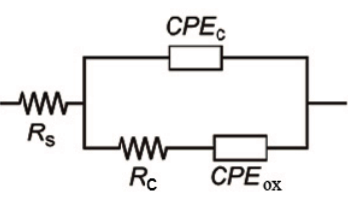
Figure 5. Equivalent electrical circuit for sintered Ag/HAP/Lig coating on titanium during initial and prolonged time of SBF exposure at 37 °C. Reprinted from [39] with permission. Copyright American Chemical Society 2013.